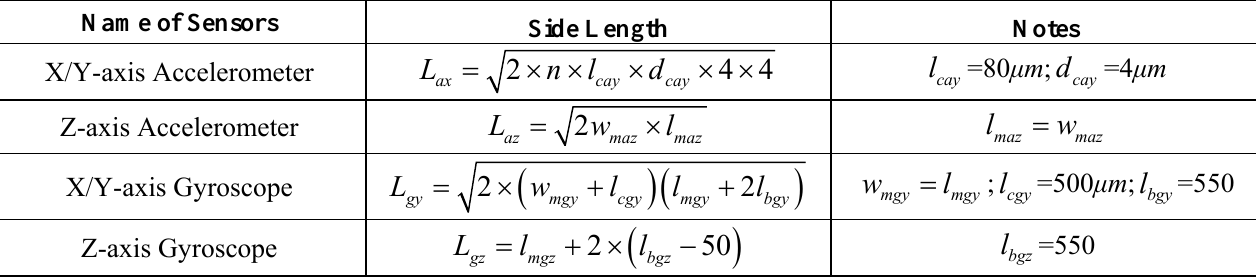
Table 2. The side length of the equivalent square for sensors in the